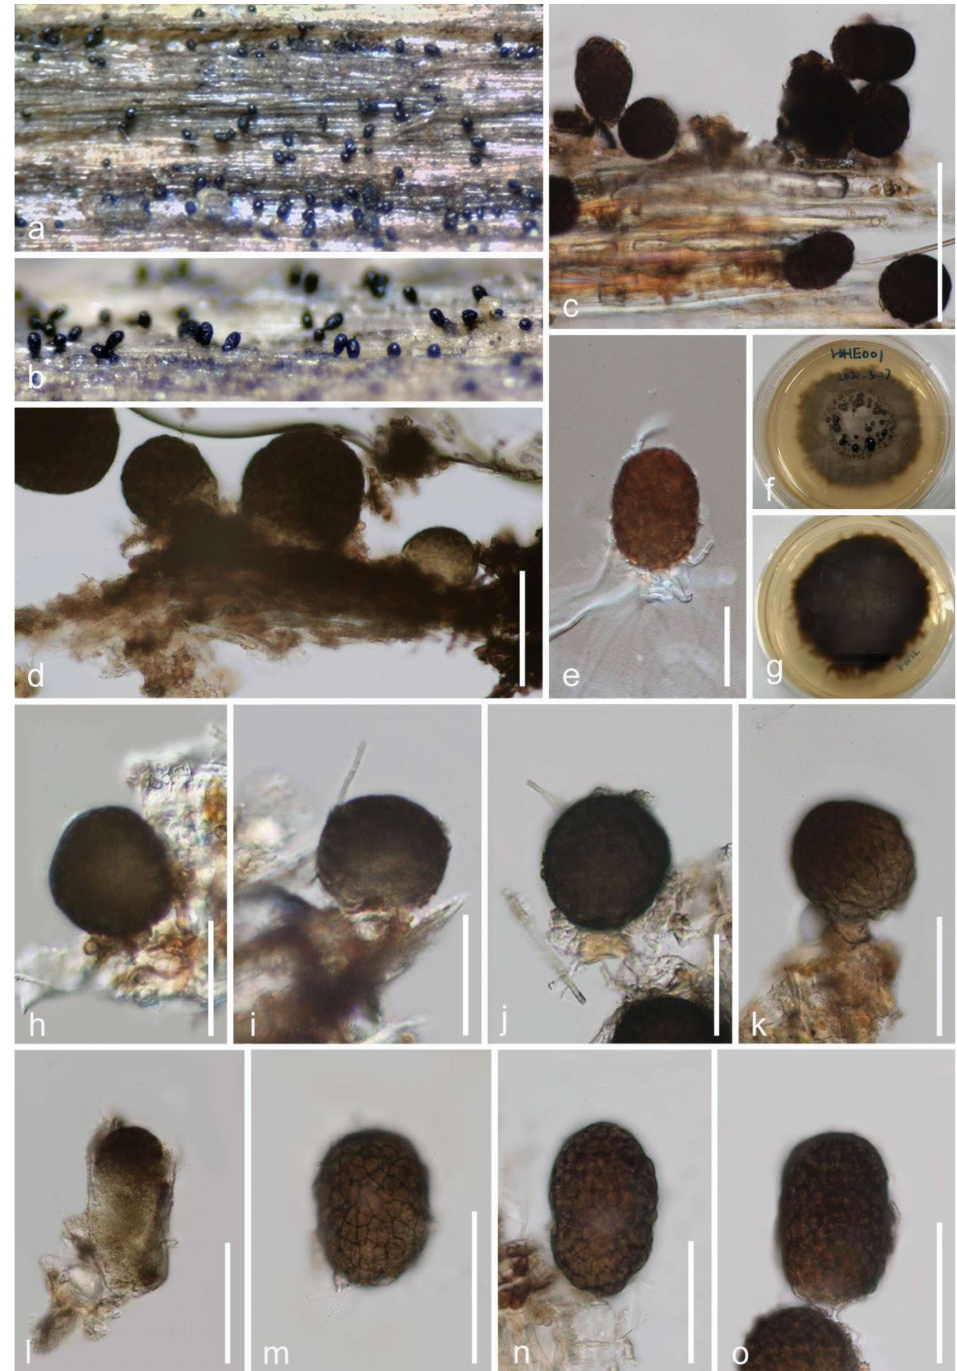
Figure 10. Paramonodictys yunnanensis (HKAS 122189, holotype). ( a , b ) Close-up of colonies on substrate; ( c , d ) conidia attached on host; ( e ) single germinated conidium; ( f , g ) colony from above and below; ( h – k ) conidia connect with conidiogenous cells; ( l – m ) immature and mature conidia. Scale bars: ( c ) = 100 µ m; ( d , e , h – o ) = 50 µ m. Paradictyoarthriniaceae Doilom, J.K. Liu and K.D. Hyde, Fungal Diversity 72: 133 (2015). Paradictyoarthrinium Matsush., Matsushima Mycological Memoirs 9: 18 (1996). Index Fungorum number: IF 554082; Faces of Fungi number: FoF 03933. Type species : Paradictyoarthrinium diffractum Matsush., Matsushima Mycological Memoirs 9: 18